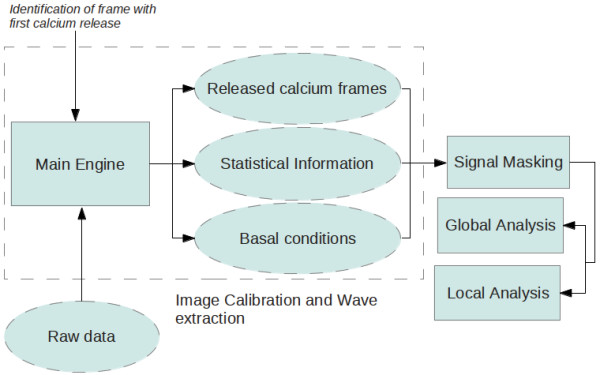
General work-flow.